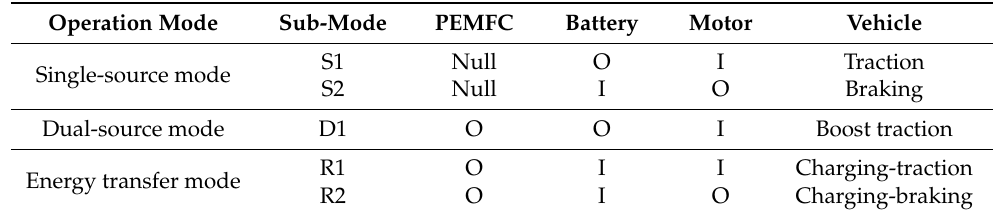
Table 1. Operation modes of the